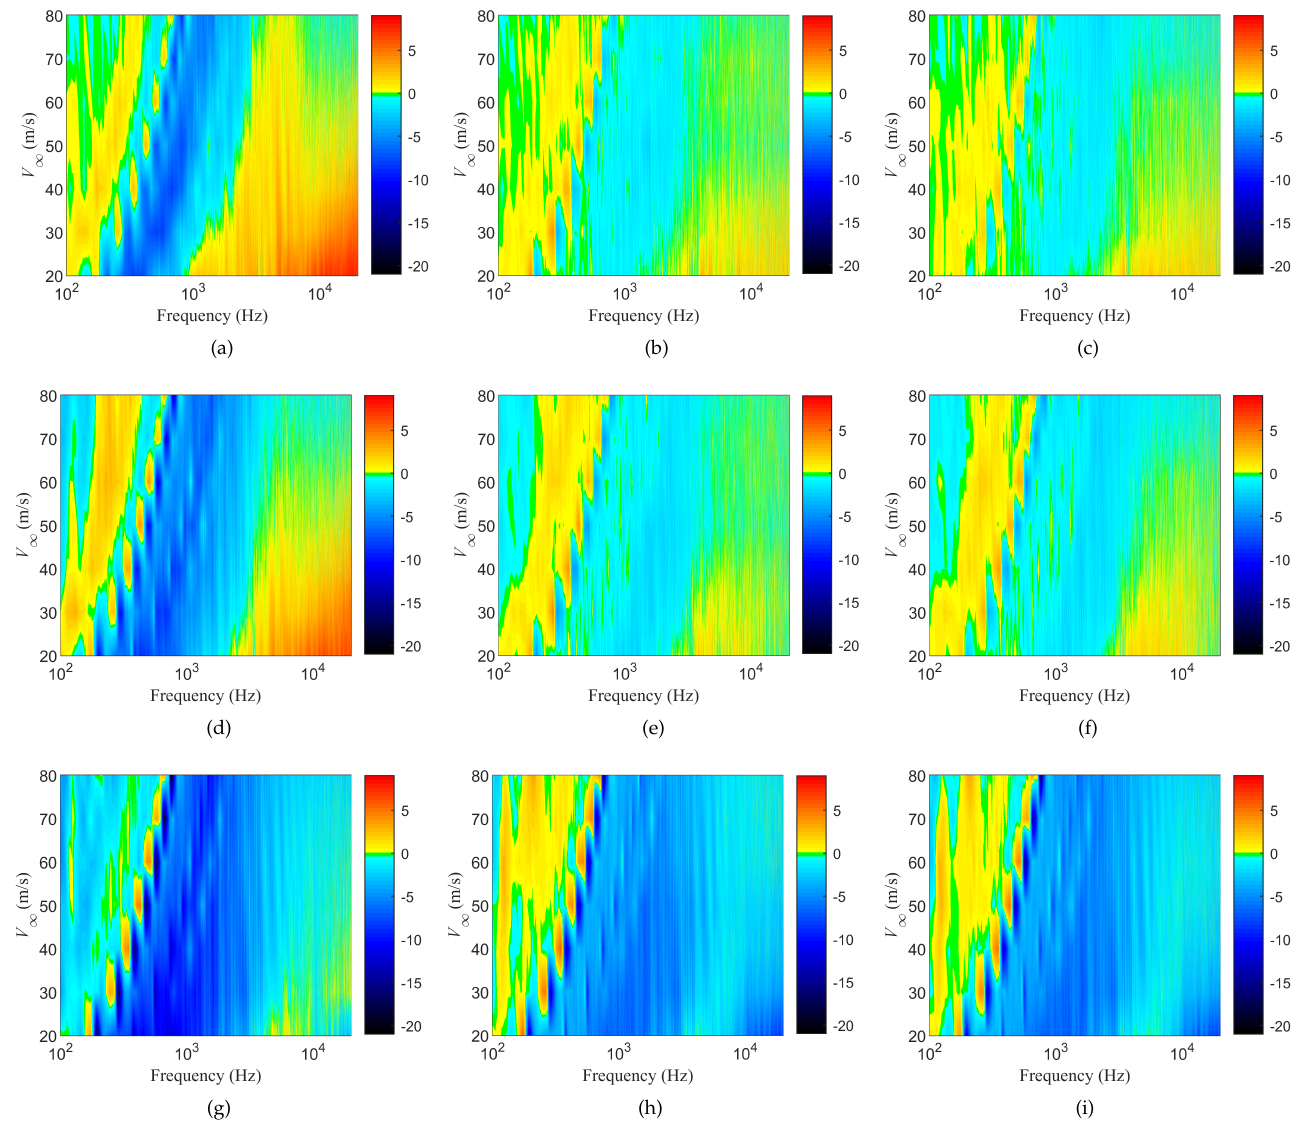
Figure 6. ∆ SPL as a function of frequency and flow velocity at different airfoil attack angles for porous leading edges with the same ppi materials ( L = 200 mm): ( a ) X40Y40Z40, α = 0 ◦ ; ( b ) X80Y80Z80, α = 0 ◦ ; ( c ) X120Y120Z120, α = 0 ◦ ; ( d ) X40Y40Z40, α = 10 ◦ ; ( e ) X80Y80Z80, α = 10 ◦ ; ( f ) X120Y120Z120, α = 10 ◦ ; ( g ) X40Y40Z40, α = 20 ◦ ; ( h ) X80Y80Z80, α = 20 ◦ ; and ( i ) X120Y120Z120, α = 20 ◦